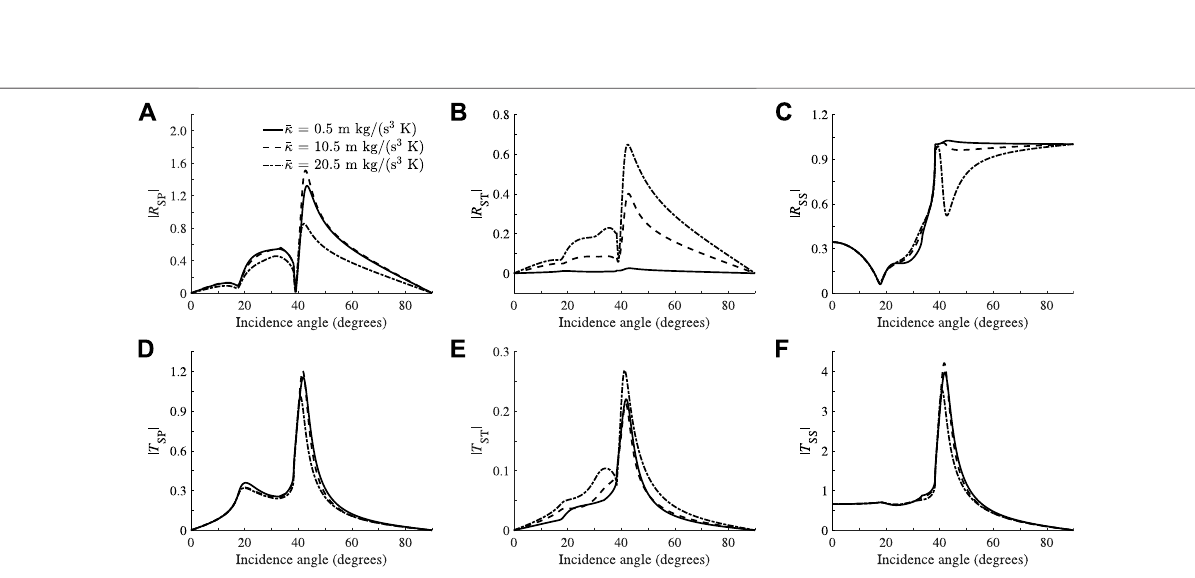
Frontiers in Earth Science |